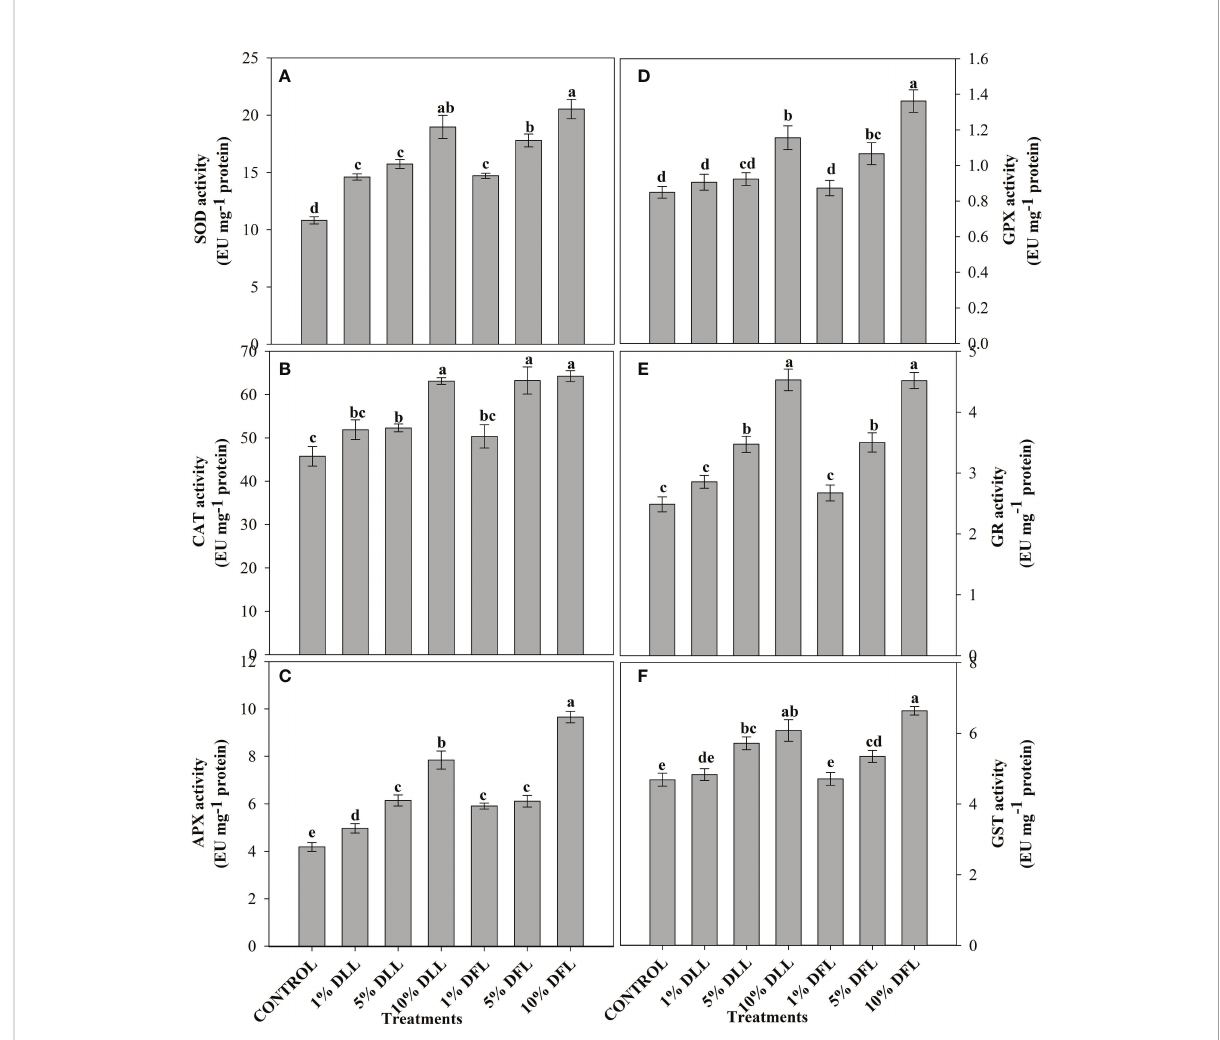
FIGURE 7 Superoxide dismutase, catalase, ascorbate peroxidase, guaiacol peroxidase, glutathione reductase, and glutathione S-transferase (EU mg -1 protein) activity (A – F) in leaves of Triticum aestivum L. plants raised using sand substrate (25 DAS) treated with leachates of dry leaves and fl owers of Tagetes erecta L. Data followed by the same letters are not signi fi cantly different at p<